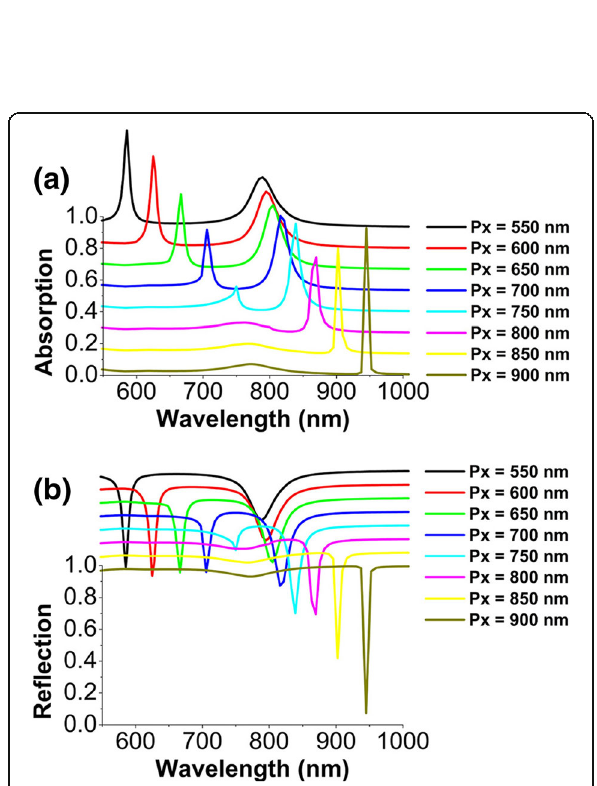
Fig. 2 Normal-incidence absorption ( a ) and reflection ( b ) spectra of metamaterials schematically shown in Fig. 1, in the wavelength range from 550 to 1000 nm. The array period p x along the x -axis direction is varied from 550 to 900 nm in steps of 50 nm. The other geometrical parameters: d = 150 nm, h = 50 nm, t = 30 nm, and p y = 500 nm. For clarity, individual spectra in a and b are vertically offset by 90 and 60% from one another,